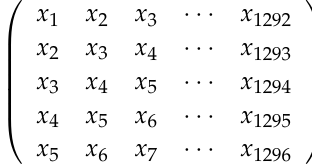
Figure 5. Forecasting results for trend of each model after removing the periodicity.